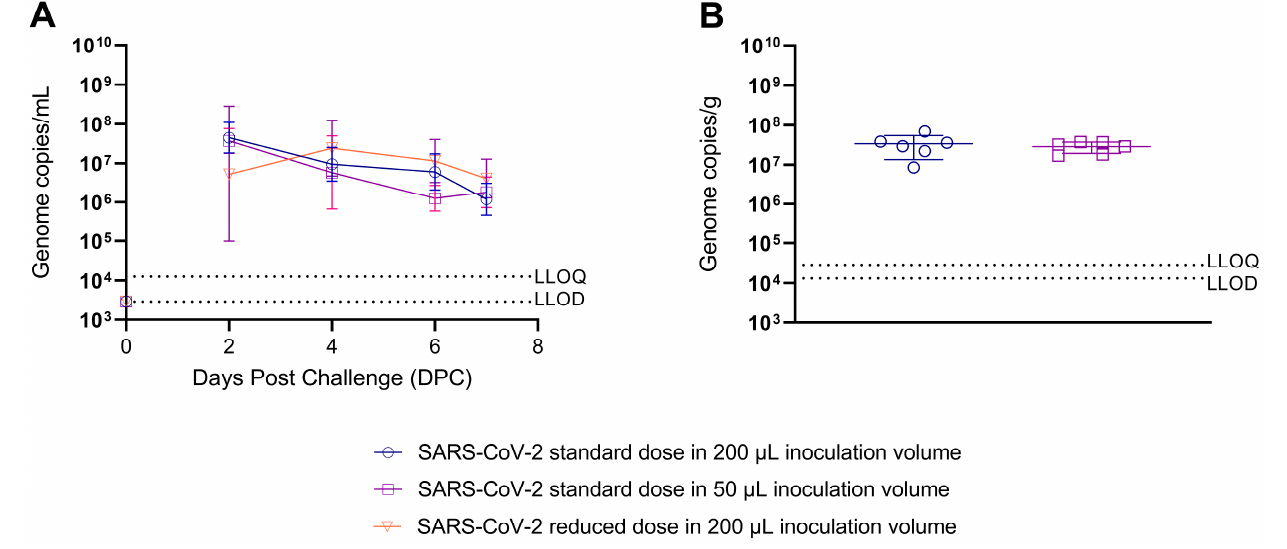
Figure 3. Quantitative polymerase chain reaction (qPCR) analysis of viral shedding and viral load in hamsters challenged with SARS-CoV-2 delivered in varied inoculum volumes. Standard dose of SARS-CoV-2 is 5 × 10 4 Plaque forming units (PFU)/mL, Reduced dose is 1 × 10 2 PFU/mL. ( A ) Viral shedding qPCR analysis in throat swab samples taken at 2, 4, 6 and 7 DPC. Lines indicate geomeans and bars indicate 95% confidence intervals. ( B ) Viral load qPCR analysis in lung tissue samples taken 7 DPC. Lines indicate geomeans and bars indicate 95% confidence intervals. No significant difference was detected by one-way ANOVA.